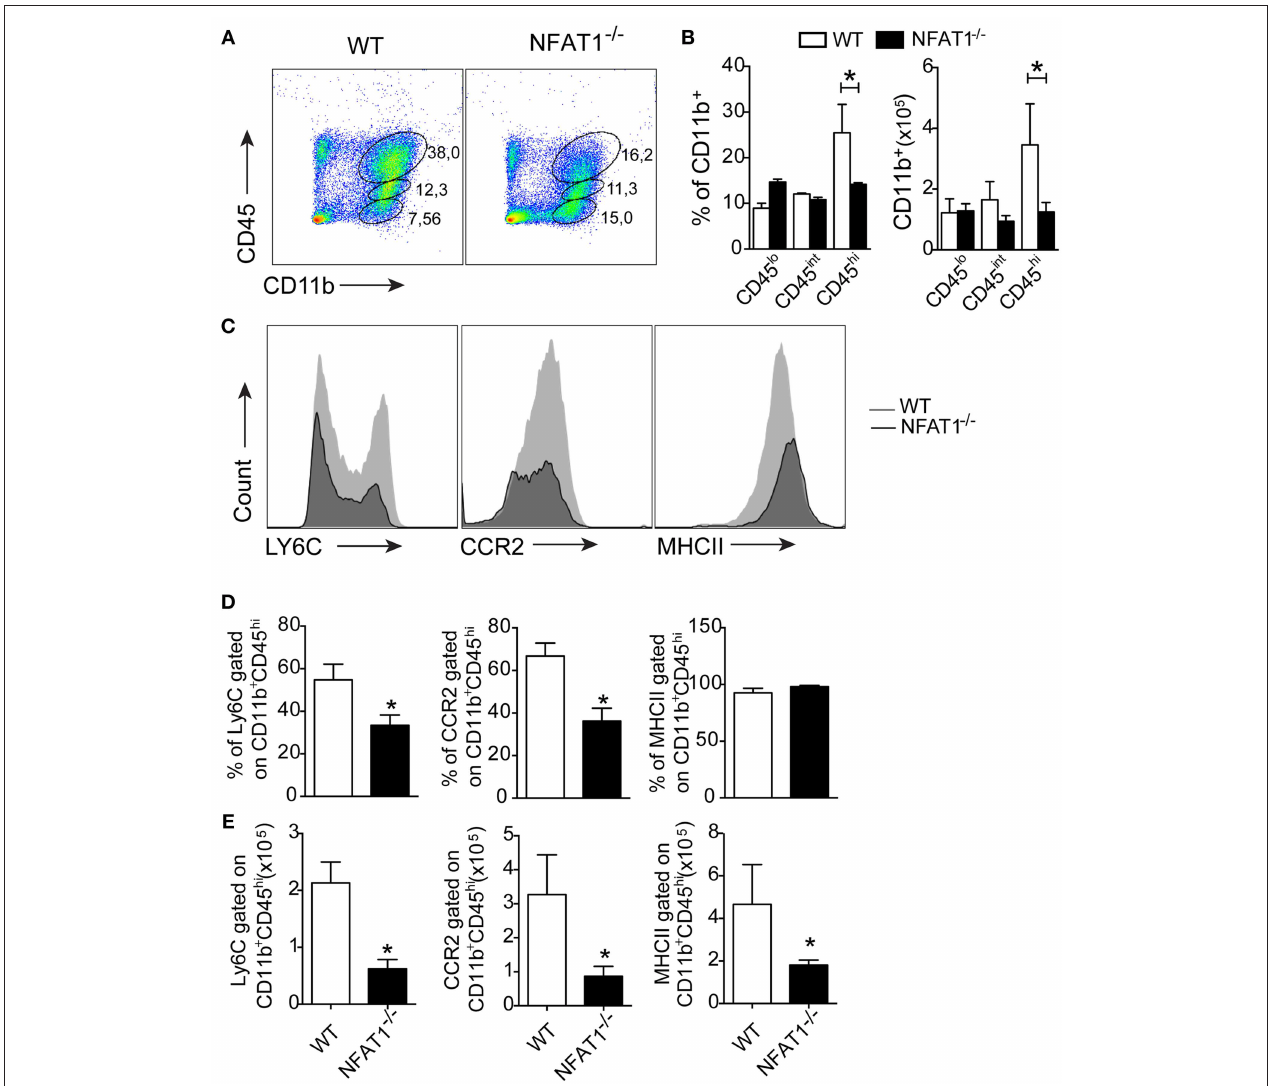
FIGURE 2 | Deletion of NFAT1 results in failure of myeloid cell recruitment to the CNS. Mononuclear cells were isolated from the CNS of WT and NFAT1 − / − mice on day 25 post-infection with 100 cysts of the ME-49 strain of T. gondii . Dot plots (A) and bar graphs (B) show the percentage and the absolute number of myeloid (CD11b + CD45 hi ), activated microglia (CD11b + CD45 lo ) and resting microglia (CD11b + CD45 − ) populations obtained by flow cytometry. Representative histograms of the expression levels of LY6C, CCR2 and MHCII surface marker of the CD11b + CD45 hi population are shown (C) . Bar graphs show the percentage (D) and absolute number (E) of cells positive for LY6C, CCR2 and MHCII of the myeloid cells (CD11b + CD45 hi ) in the CNS from the WT and NFAT1 − / − mice at 25 dpi. Data are the mean ± SEM of the five mice per experimental group of two independent experiments (* P <